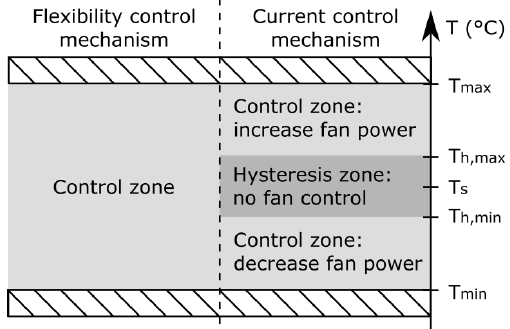
Figure 1. Graphical representation of control zones for non-VSD controlled cooling